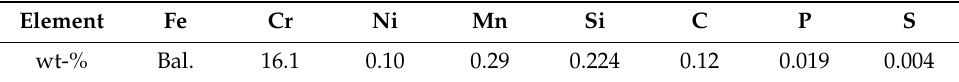
Table 1. Chemical compositions of AISI 430 ferritic stainless steel (FSS).